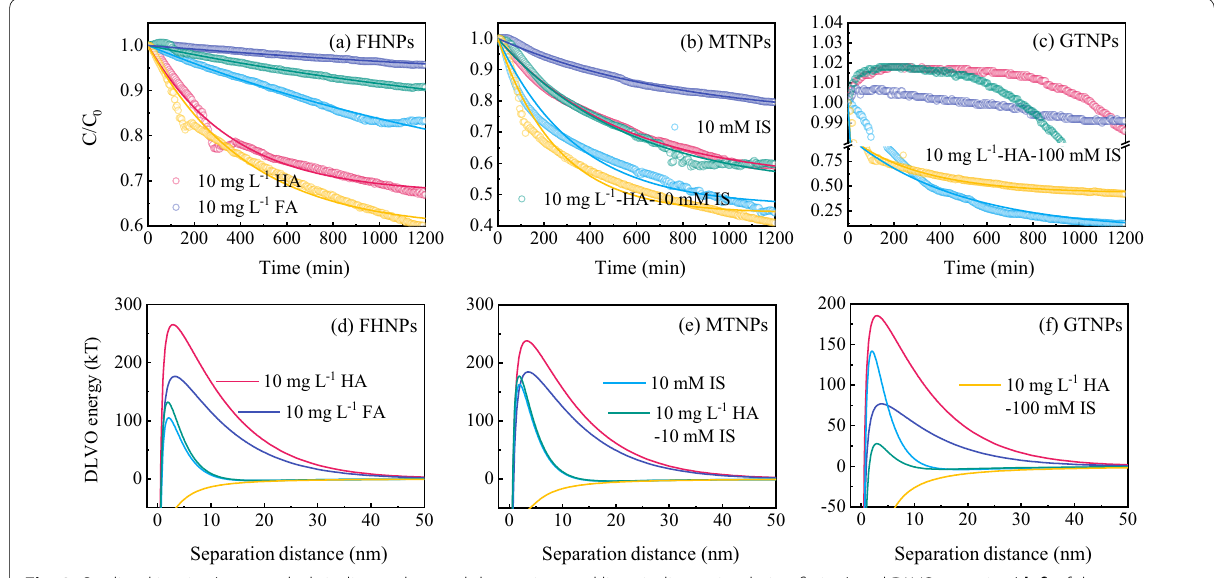
Fig. 3 Settling kinetics ( a – c , symbols indicate observed data points and lines indicate simulation fitting) and DLVO energies ( d – f ) of the BCNPs-IMNPs (0.02 g IM) at pH 7.0 with varying DOM species and